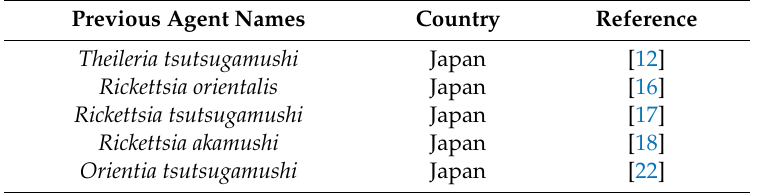
Table 3. Previous and Current Names of the Scrub Typhus Agent from the Tsutsugamushi